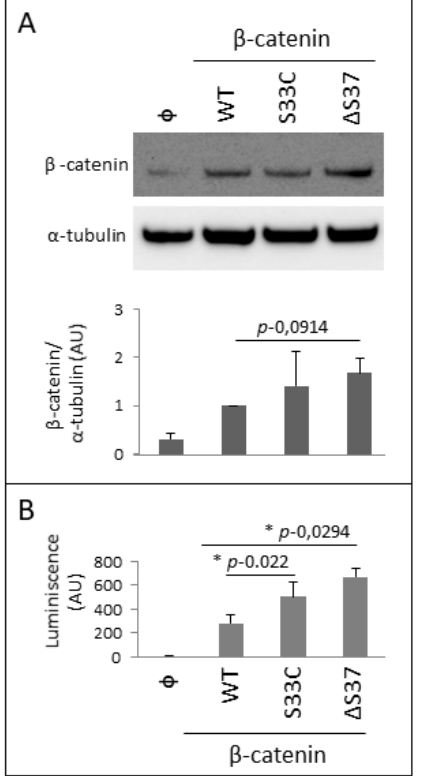
Figure 6. Functional characterization of the novel β -catenin variant c.109-111del (p.Ser37del). ( A ): Top panel. Immunoblot of endogenous β -catenin ( ϕ ), and recombinant β -catenin wild-type (WT) and S33C and ∆ S37 variants. U2OS cells were transfected with empty vector ( ϕ ) or with plasmids containing the indicated β -catenin variants. Cell lysates were resolved on 4–10% SDS-PAGE under reducing conditions followed by immunoblot using anti- β -catenin antibody. Anti- α -tubulin was used to monitor protein loading. Bottom panel. Plot showing β -catenin/ α -tubulin ratio, in arbitrary units (AU), from quantified immunoblot bands from two independent experiments ± SD. ( B ): Transcriptional activity of β -catenin variants. SEAP-normalized TCF/LEF-driven luciferase activity of β -catenin from U2OS transfected cells, as described in top panel. Luminescence is shown in arbitrary units (AU), from three independent experiments. Statistically significant results ( p < 0.05) are marked with *.